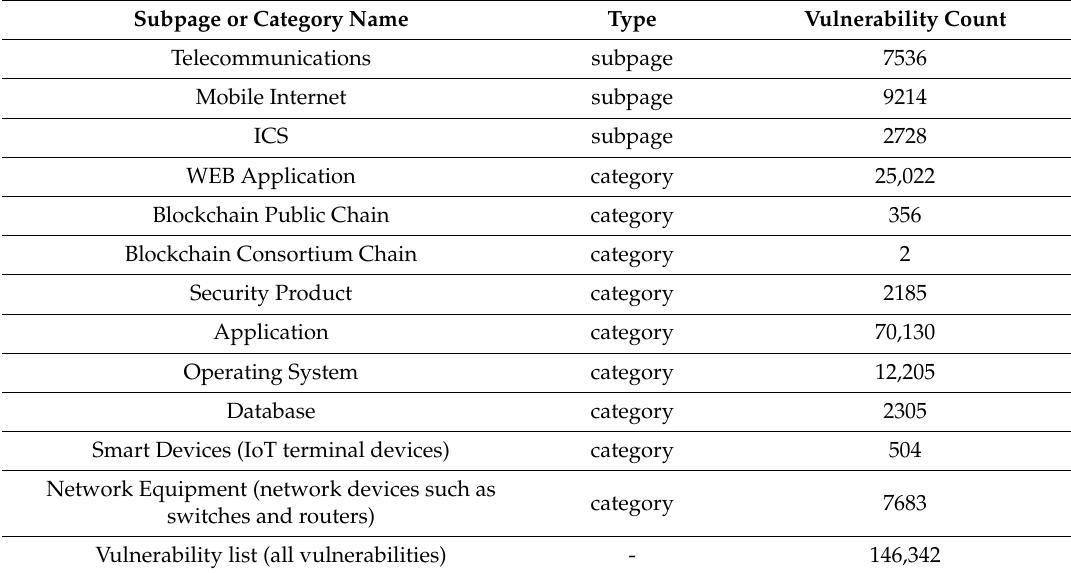
Table 3. List of CNVD vulnerability categories and subpages. Vulnerability counts presented as of 25th August 2020. Own work based on [27].